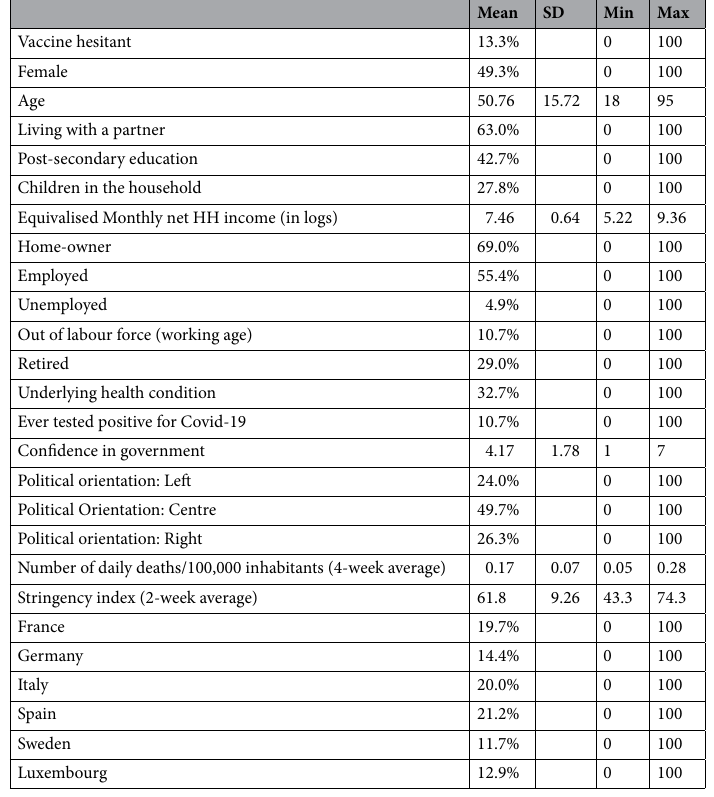
Table 1. Descriptive statistics of the estimation sample. These figures refer to our estimation sample. Percentages are reported instead of decimal means for dummy variables. “Vaccine hesitant” are those who replied “No, I do not plan to” to the question “Have you been vaccinated against Covid-19?”. “Post-Secondary Education” is a dummy for individuals with a college degree. “Confidence in Government” is the respondent’s degree of confidence in the government’s ability to handle the COVID-19 crisis (measured on a Likert scale from 1 to 7). “Stringency Index” is an index produced by the Blavatnik School of Governance of the University of Oxford composed of nine sub-indices measuring the various aspects of containment policies, and has been rescaled to range from 0 to